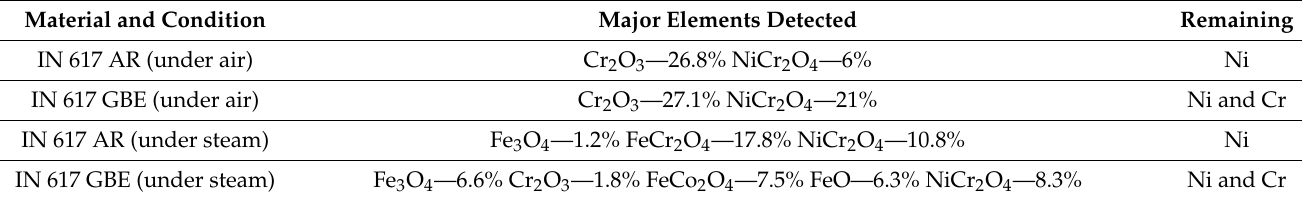
Figure 10. XRD pattern of initial, air-oxidised and steam-oxidised IN 617 alloy. Table 5. Oxides detected in XRD under Rietveld analyis